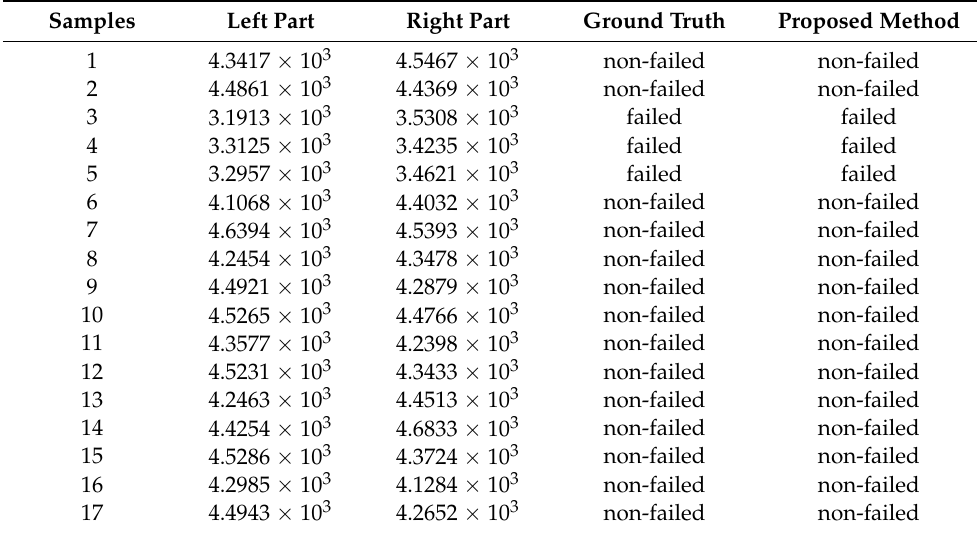
Table 2. The results of the proposed method.